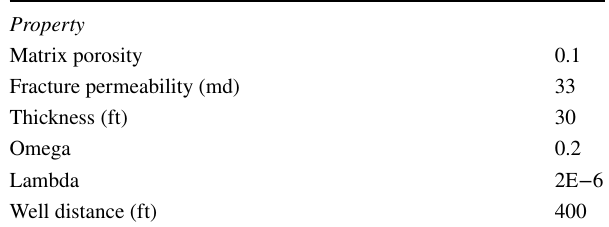
Table 2 Properties of fractured reservoir model